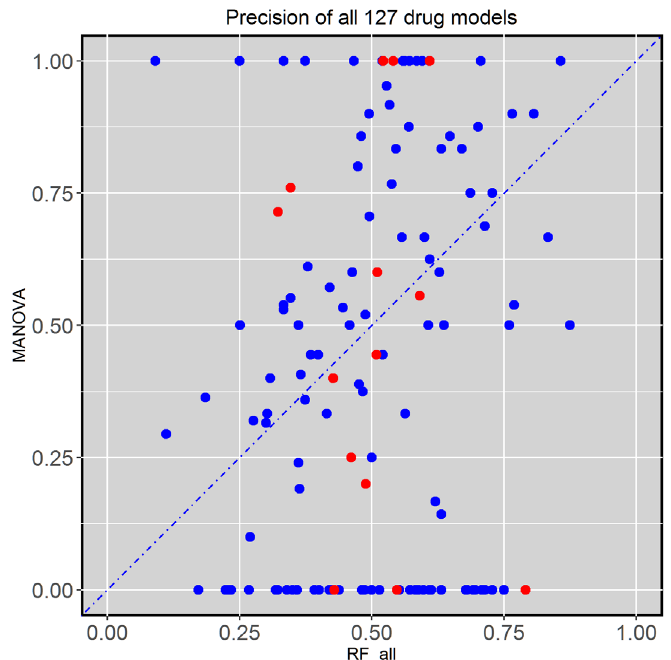
Figure 2. Test set precision of MANOVA single-gene markers versus RF transcriptomic models across the 127 drugs. A large variability is observed, with 66 drugs obtaining better precision with Random Forest (RF) classifiers using all transcriptomic features. Cytotoxic drugs are in red and targeted drugs are in